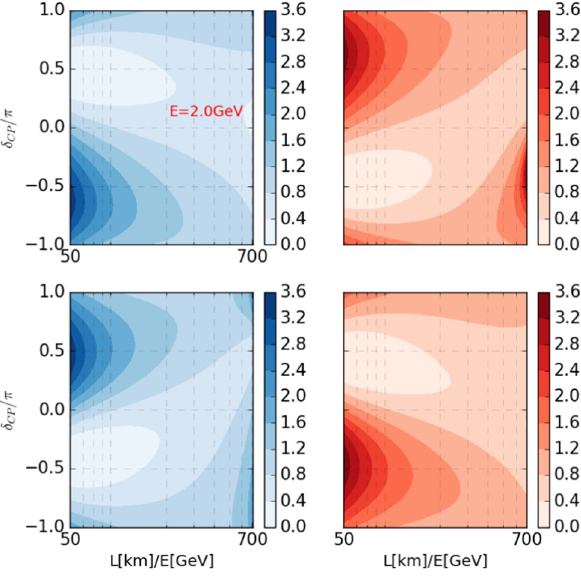
Fig. 8 Same as Fig. 5 but the reference energy E = 5 . 0 GeV has been fixed to the flux peak energy of an arbitrary future experiment the oscillation maxima at 1.4 GeV for NH and at 1.8 GeV for IH.NO ν Astartedtakingdatain2014andtookdatauntil2019 release [12], these correspond to 8 . 85 × 10 20 ( 6 . 9 × 10 20 ) POTs, for neutrino (anti-neutrino)